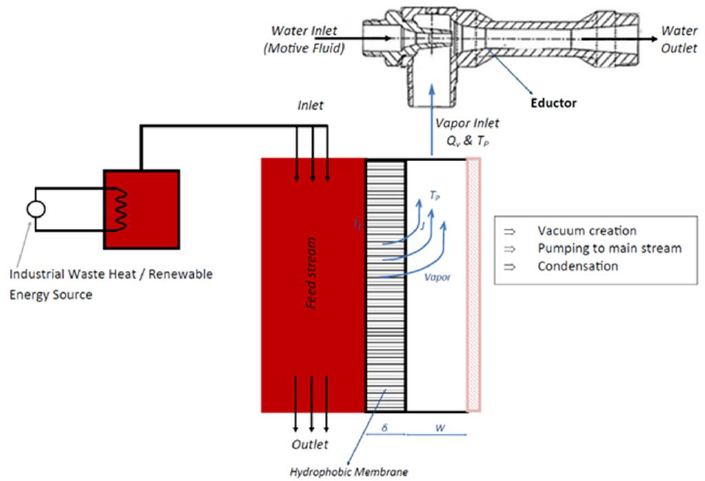
Figure 20. Eductor-based MD